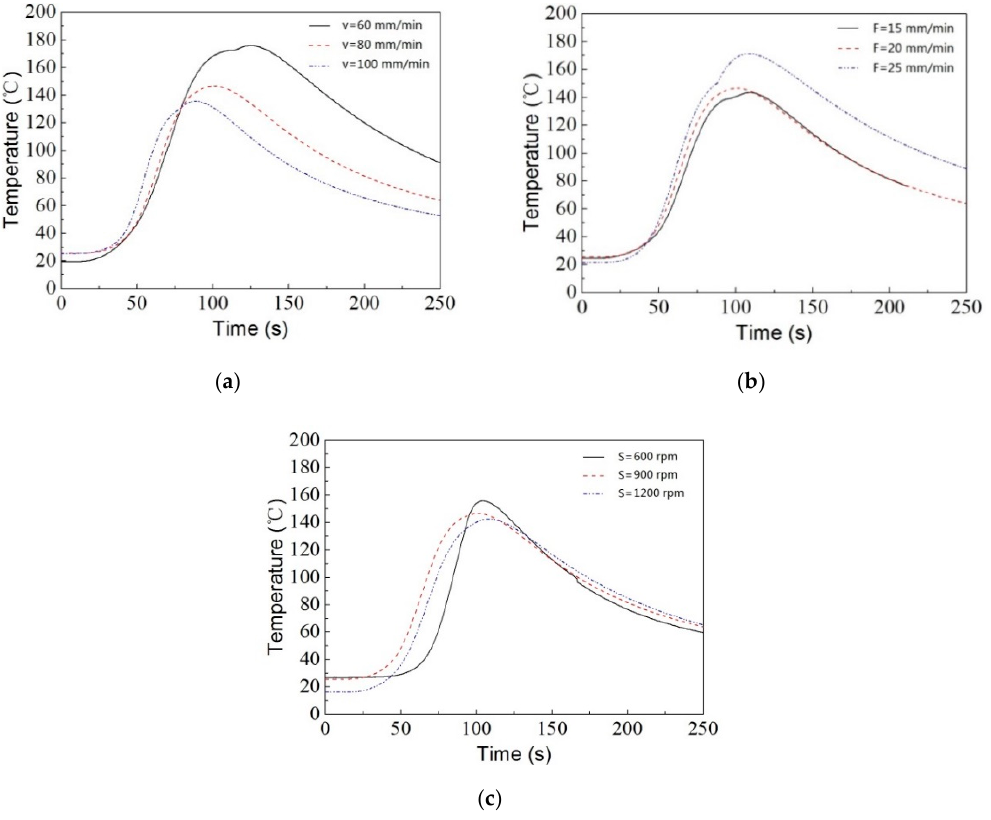
Figure 9. Temperature evolution at point CH01: ( a ) S = 900 rpm, F = 20 mm/min; ( b ) S = 900 rpm, V = 80 mm/min; ( c ) V = 80 mm/min, F = 20 mm/min.